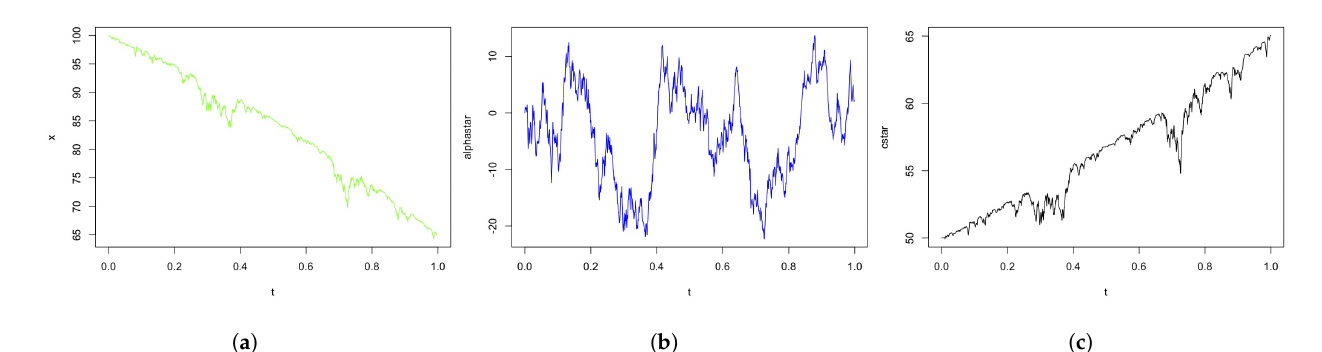
Figure 2. The wealth process with the parameters α and c when σ = 1, r = 0.01 and κ = 0.5. ( a ) The wealth process X ∗